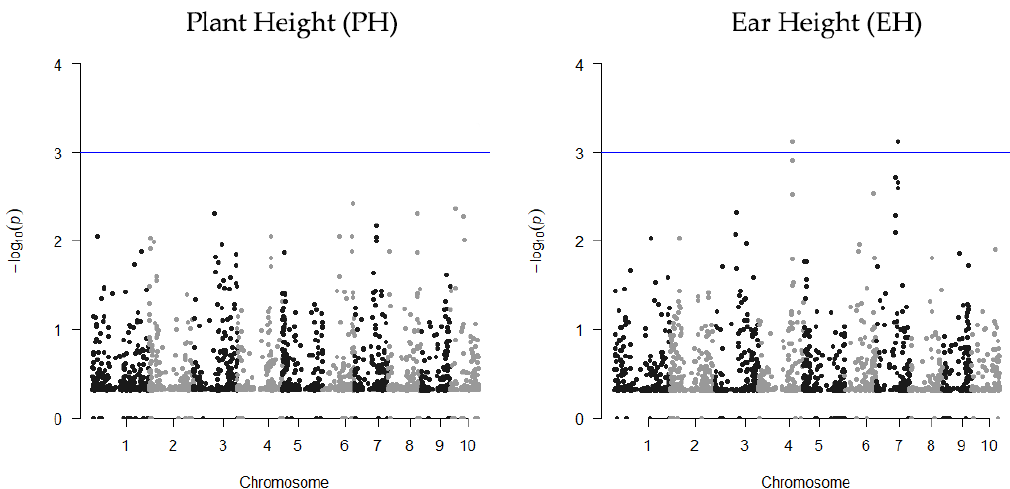
Figure 4. Manhattan plots of the statistical significance of the genomic regions associates with the GY, PE, PH, and EH traits in Itaocara (ENV2). The x-axis shows chromosomal positions and the y-axis shows − log 10 p -values. The blue horizontal line represents the genome-wide significance threshold ( p -value = 1 × 10 − 3 ).